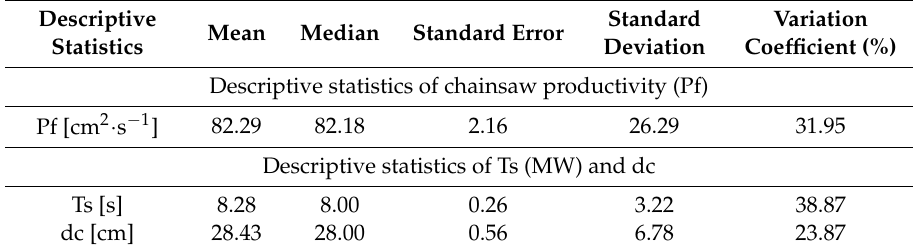
Table 8. Statistical indicators of the chainsaw productivity variation in wood cross-cutting in the felling area.